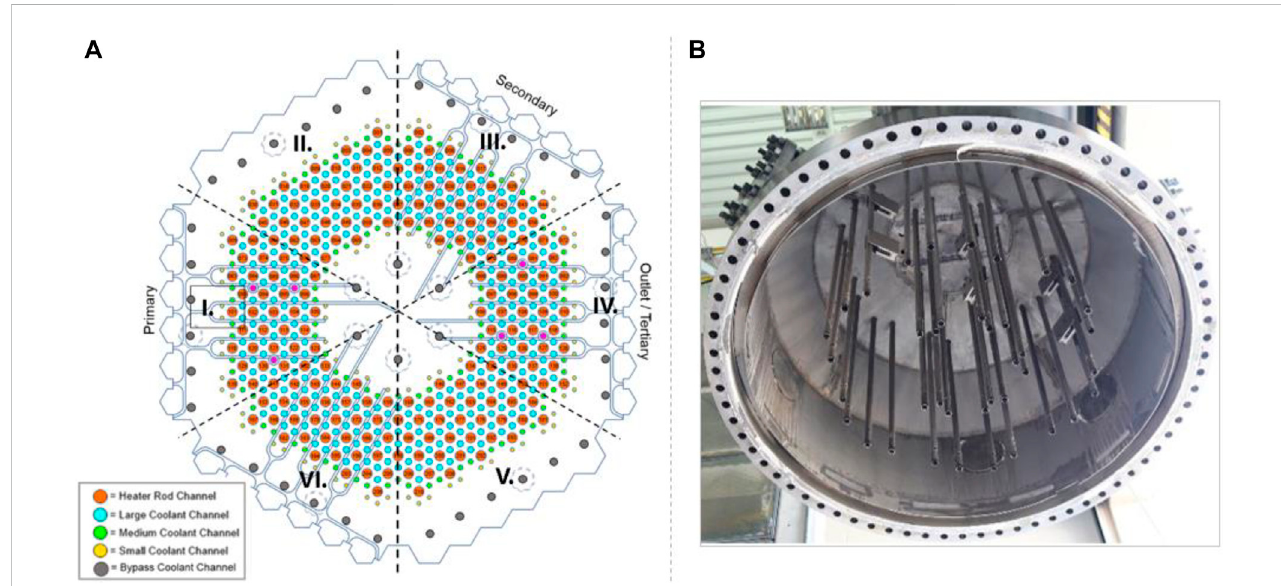
FIGURE 2 (A) Arrangement of coolant channels, bypass channels, and heater rods channels in the HTTF core block; (B) HTTF upper head with instrumented guide